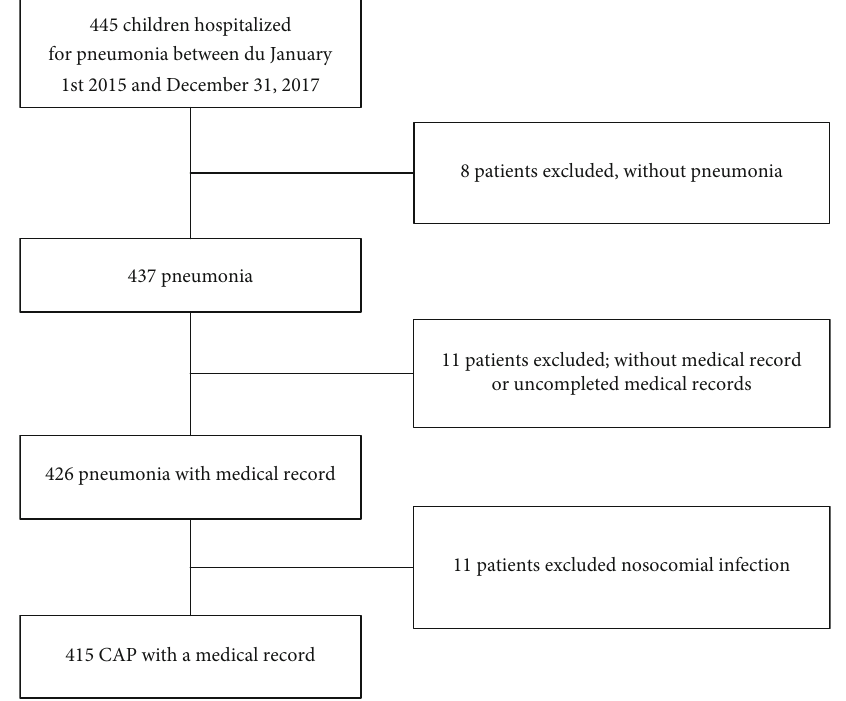
Figure 1: Flow chart of the patients included in the study.